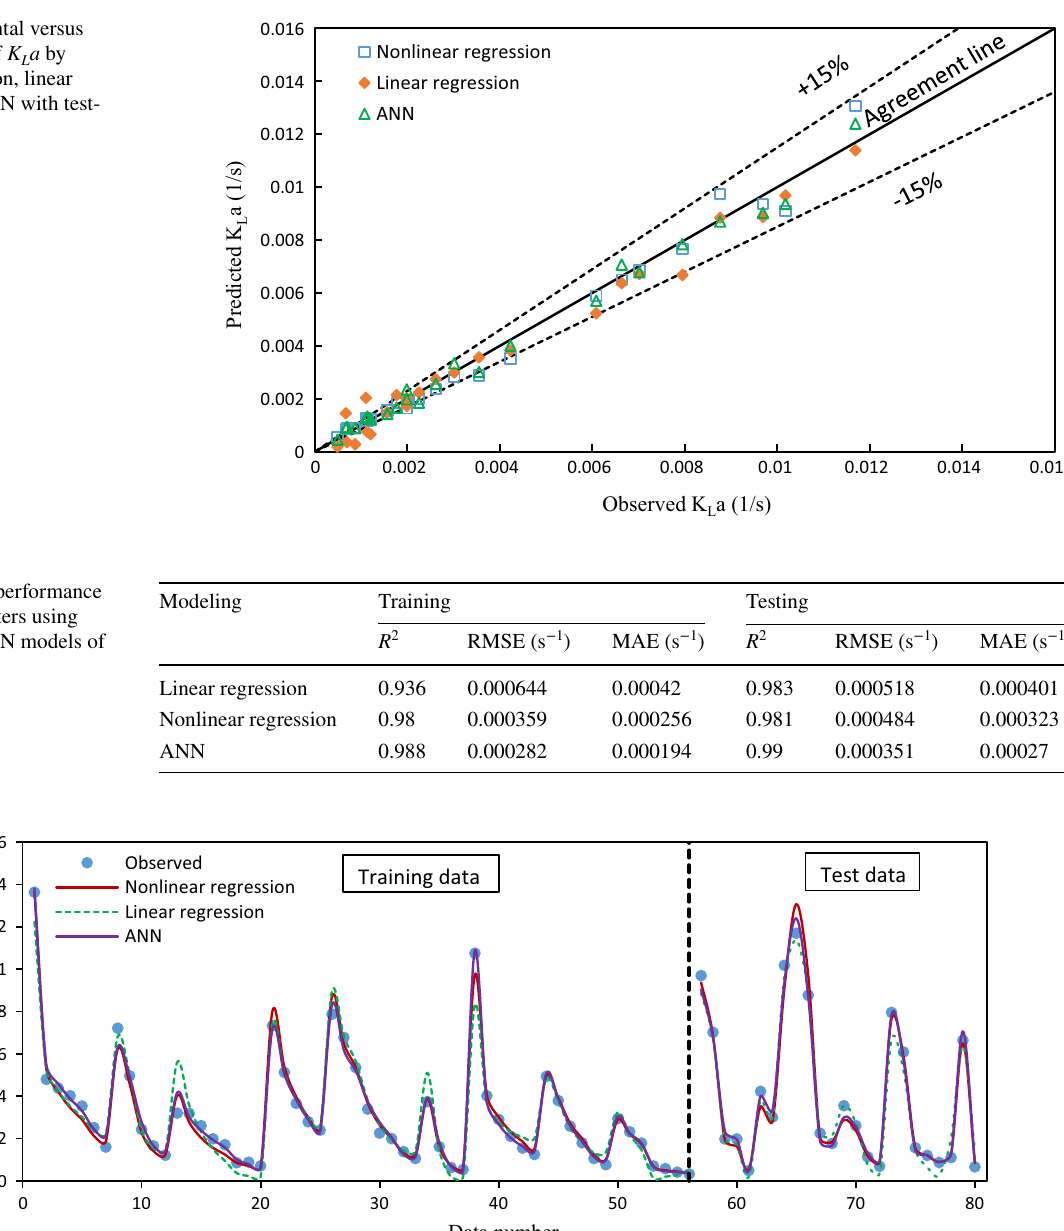
Fig. 11 Variation in predicted values of K L a using different modeling approaches in comparison with experimental values of K L a during training and testing